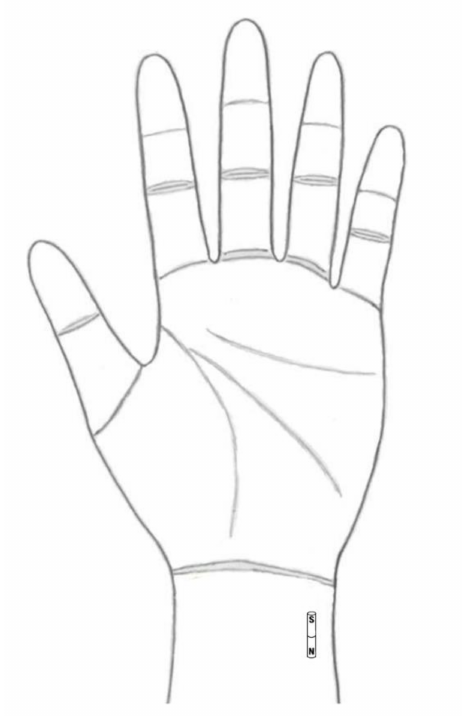
Figure 2. A pair of line-magnets is placed in line along the heart meridian. The line-magnets are positioned with N poles proximal and S poles distal (modified from [8]).